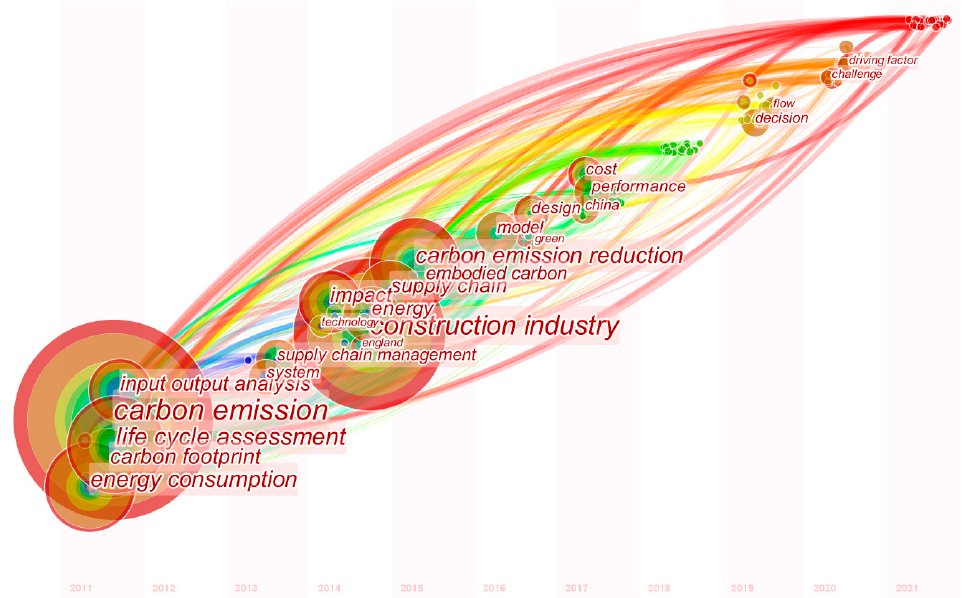
Figure 6. A visualization of LCSC keyword co-occurrence network. Table 4. Visualization of the keyword co-occurrence